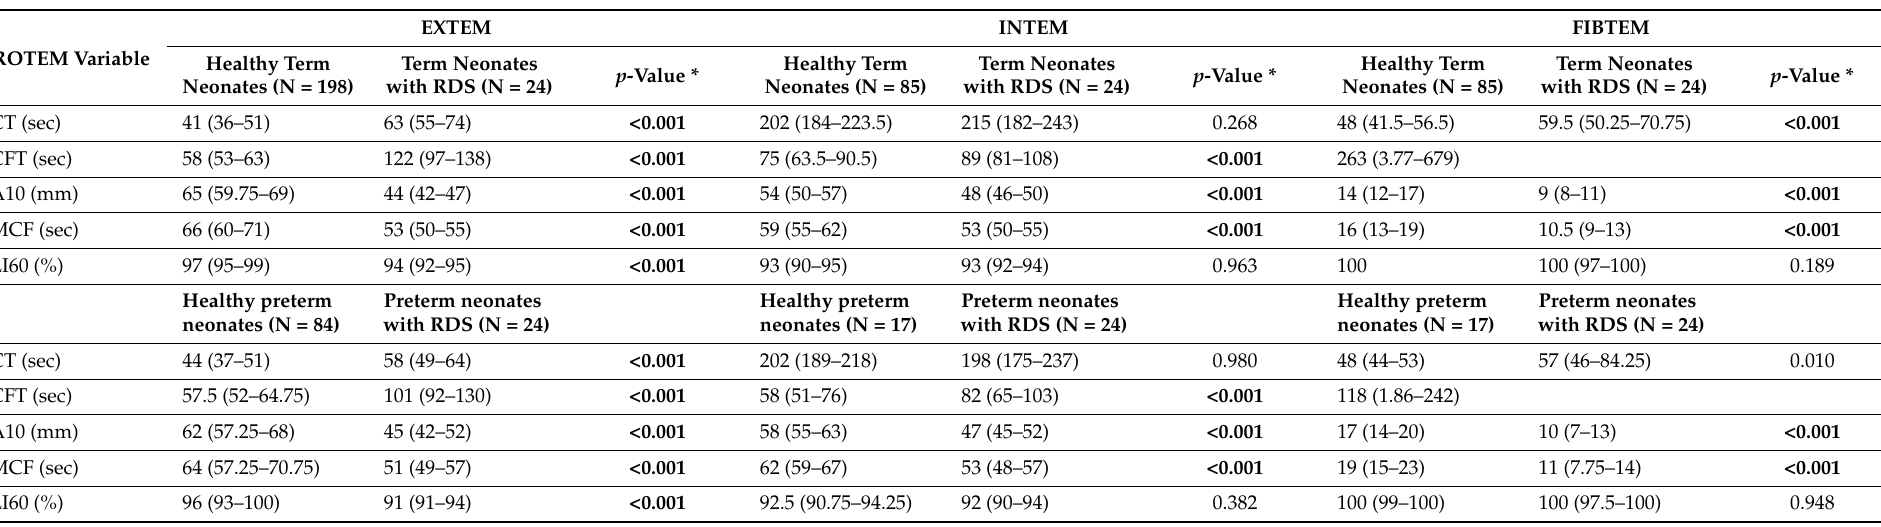
Table 3. Comparison of ROTEM parameters between healthy neonates and neonates with